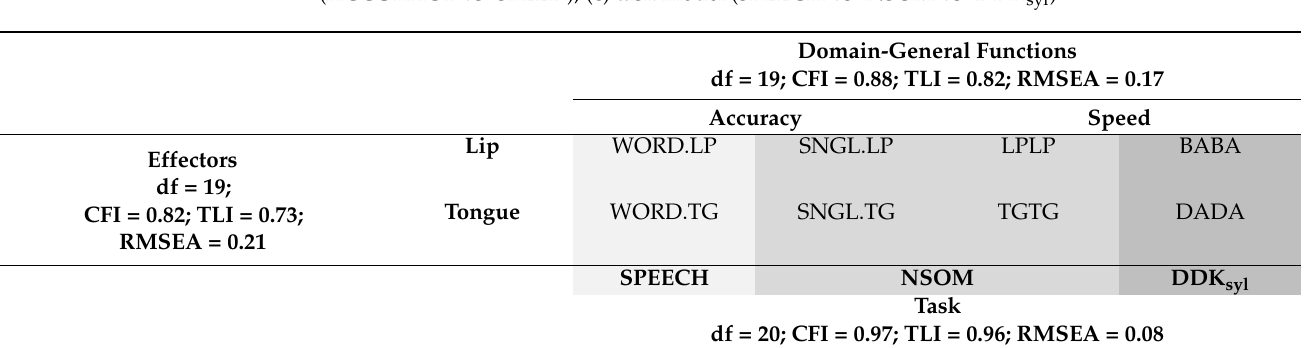
Table 5. Design of three measurement models to explain the covariance structure of lip and tongue motor actions in consonant accuracy during word production (SPEECH; light grey), in isolated and repetitive single articulator movements (NSOM; grey), and syllable DDK (dark grey) through confirmatory factor analyses. (a) Effector model (LIP vs. TONGUE), (b) functional goal